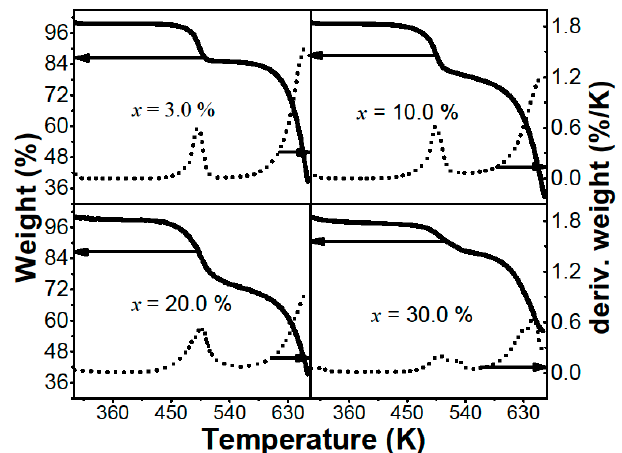
Figure 3. Thermogravimetry (TGA) thermographs with their derivatives (pointed lines referred to the right-hand scale) for different (PEO) 10 CF 3 COONa + x wt.% Al 2 O 3 composites.